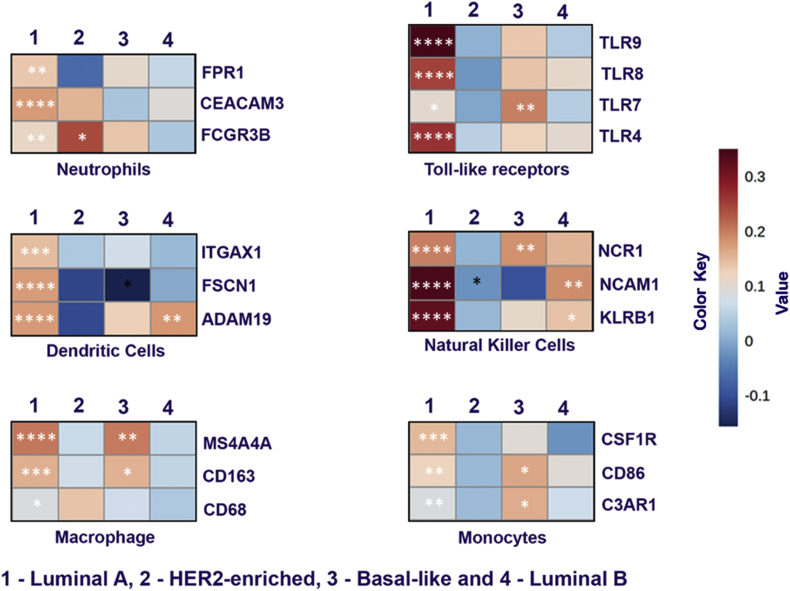
ACE2 expression correlated with immune cell markers in BC subtypes. Heat map showing the Spearman correlation-based analysis with the significance of immune cell-specific markers in subtypes of breast cancer using TIMER 2.0 analysis. The markers include FPR1, CEACAM3 and FCGR3B of neutrophils, TLR4, TLR7, TLR8 and TLR9 of toll-like receptors, ITGAX1, FSCN1 and ADAM19 of dendritic cells, NCR1, NCAM1 and KLRB1 of natural killer cells, MS4A4A, CD163 and CD68 of macrophages and CSF1R, CD86 and C3AR1 of monocyte cells.